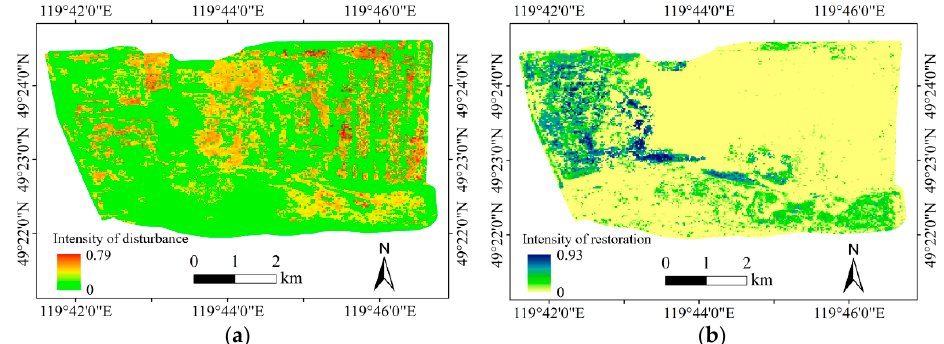
Figure 11. Intensity of disturbance and restoration of the vegetation. ( a ) Intensity of the disturbance; ( b ) Intensity of restoration.